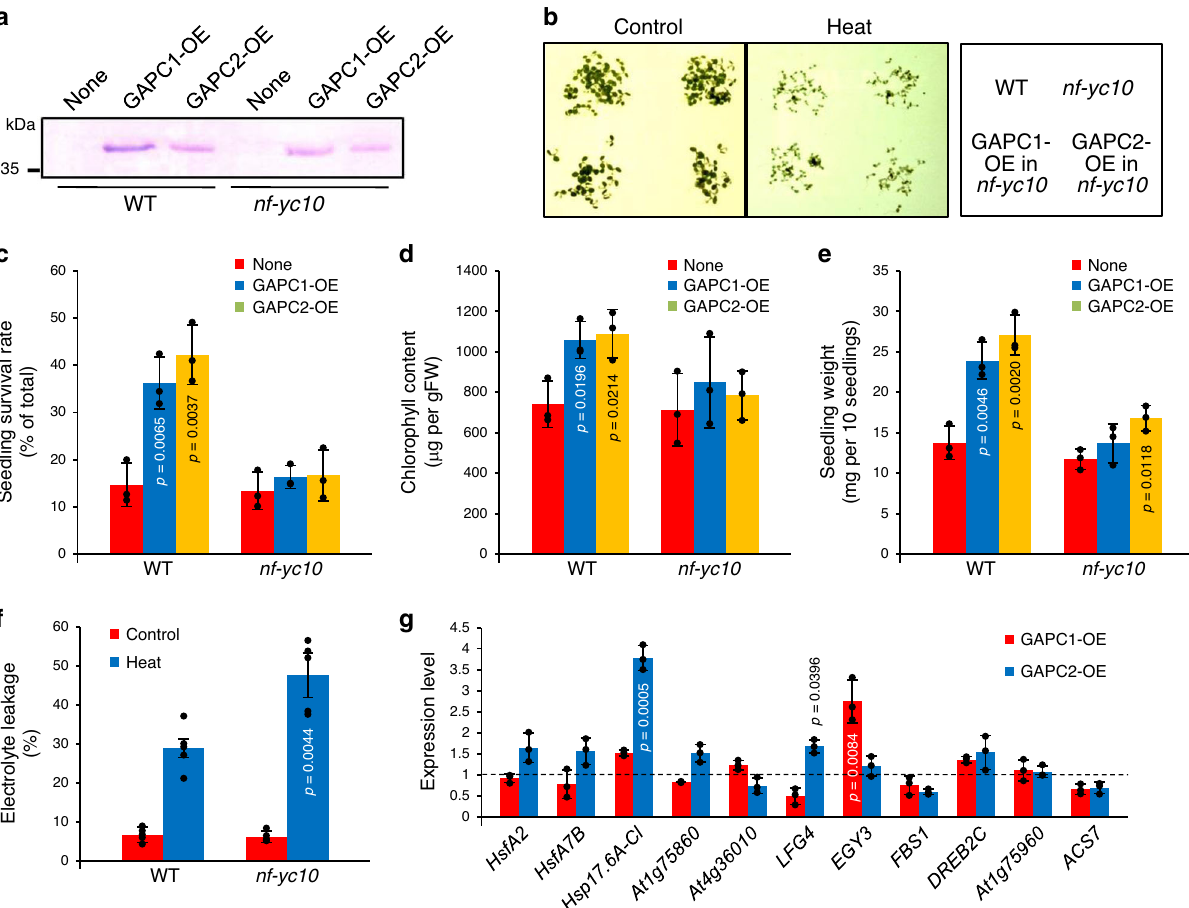
Fig. 5 Effects of GAPC overexpression in nf-yc10 on heat response. a Immunoblotting of GAPC. Total proteins were extracted from 5-day-old transgenic seedlings overexpressing GAPC-Flag as indicated on the top in the background plants indicated at the bottom. GAPC was probed with an anti-Flag antibody by immunoblotting. b Representative images of heat-treated plants. Five-day-old seedlings were untreated (Control) or treated at 40 °C for 6 h, then placed back to normal temperature condition. Images were taken after 2 days of heat shock. c – e Quantitative measurements of heat response. Plants with genetic background indicated on the x-axis were treated at 40 °C for 6 h and measured for seedling survival rate ( c ), chlorophyll content ( d ), and seedling weight ( e ). Values are average ± S.D. P values indicate signi fi cant difference from background line (None) determined by two-tailed student ’ s t test ( n = 3 independent groups of >30 seedlings). Black dots represent individual data points. FW, fresh weight. f Electrolyte leakage of WT and nf-yc10 . Conductivity was measured with rosette leaves from 3-week-old plants immediately after heat treatment at 40 °C for 6 h. Electrolyte leakage was calculated and shown here as % conductivity of total ions (boiled sample). Values are average ± S.D. P values indicate signi fi cant difference from WT determined by two-tailed student ’ s t test ( n = 5 leaves from independent plants). Black dots represent individual data points. g Expression of heat-inducible genes. Total RNA was extracted from 5-day-old seedlings treated at 37 °C for 5 h and quantitative RT-PCR was performed with gene-speci fi c primers. Values are average ± S.D. and shown as fold change to background line ( nf-yc10 ; dashed line). P values indicate signi fi cant difference from nf-yc10 determined by two-tailed student ’ s t test ( n = 3 independent groups of >10 seedlings). Black dots represent individual data